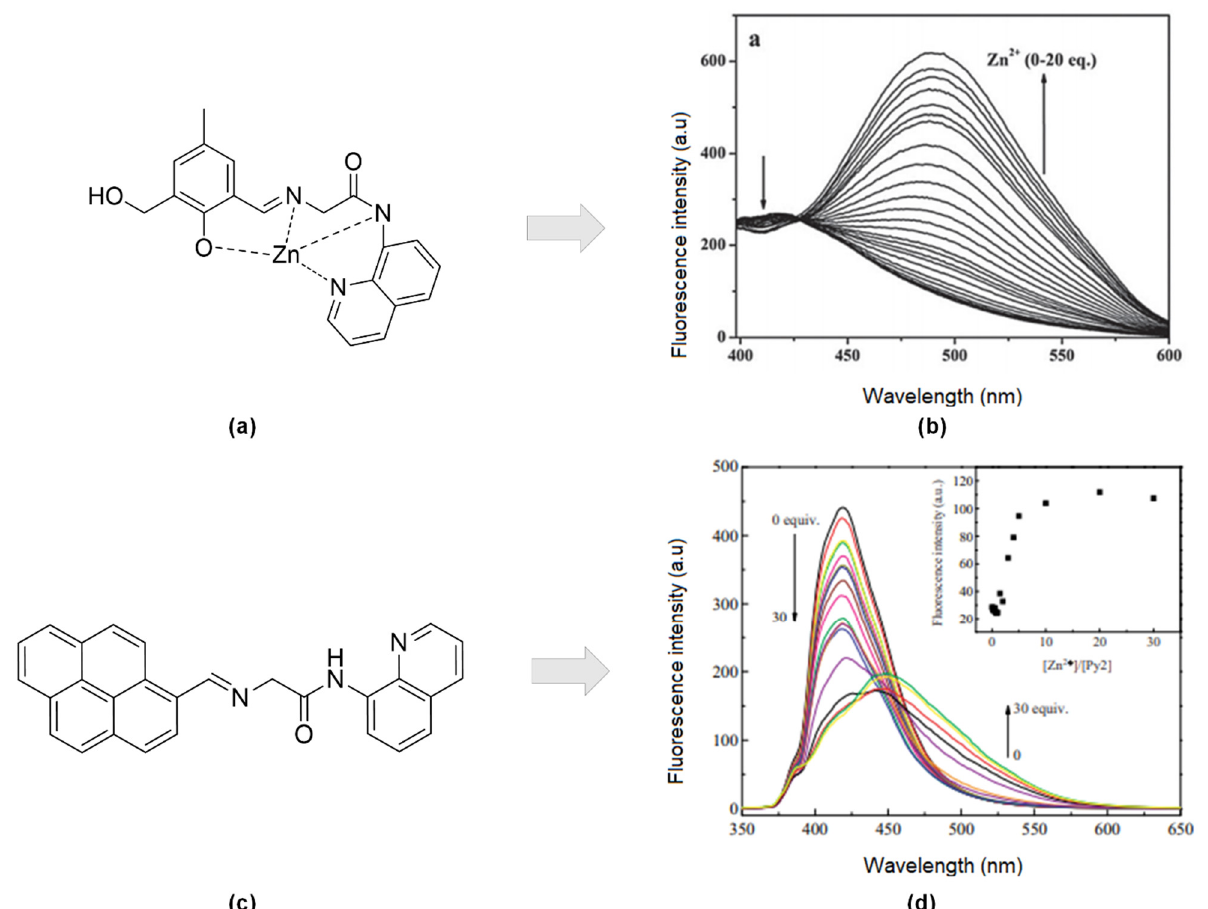
Figure 6. ( a ) Formation of (E)-2-((2-hydroxy-3-(hydroxymethyl)-5-methylbenzylidene)amino) -N-(quinoline -8-yl) acetamide-Zn at ratio 1:1. ( b ) Fluorescence spectra of L1 (10 mM) was titrated with Zn 2+ (0–20 equiv) in buffer (CH 3 CN–Tris-HCl buffer solution (50 mM Tris, 50:50, v / v , pH 7.2). ( c ) Structure of (E)-2-((pyren -1-yl methylene)amino)-N-(quinolin-8-yl)acetamide (Py2). ( d ) Fluorescence spectra of 10 µ M Py2 in aqueous solution (water-EtOH) in the presence of different concentrations of Zn 2+ (0–30 equiv), λ ex = 340 nm. Inset: Plots of fluorescence responses changes upon binding to different concentration of Zn 2+ at λ em = 500 nm.